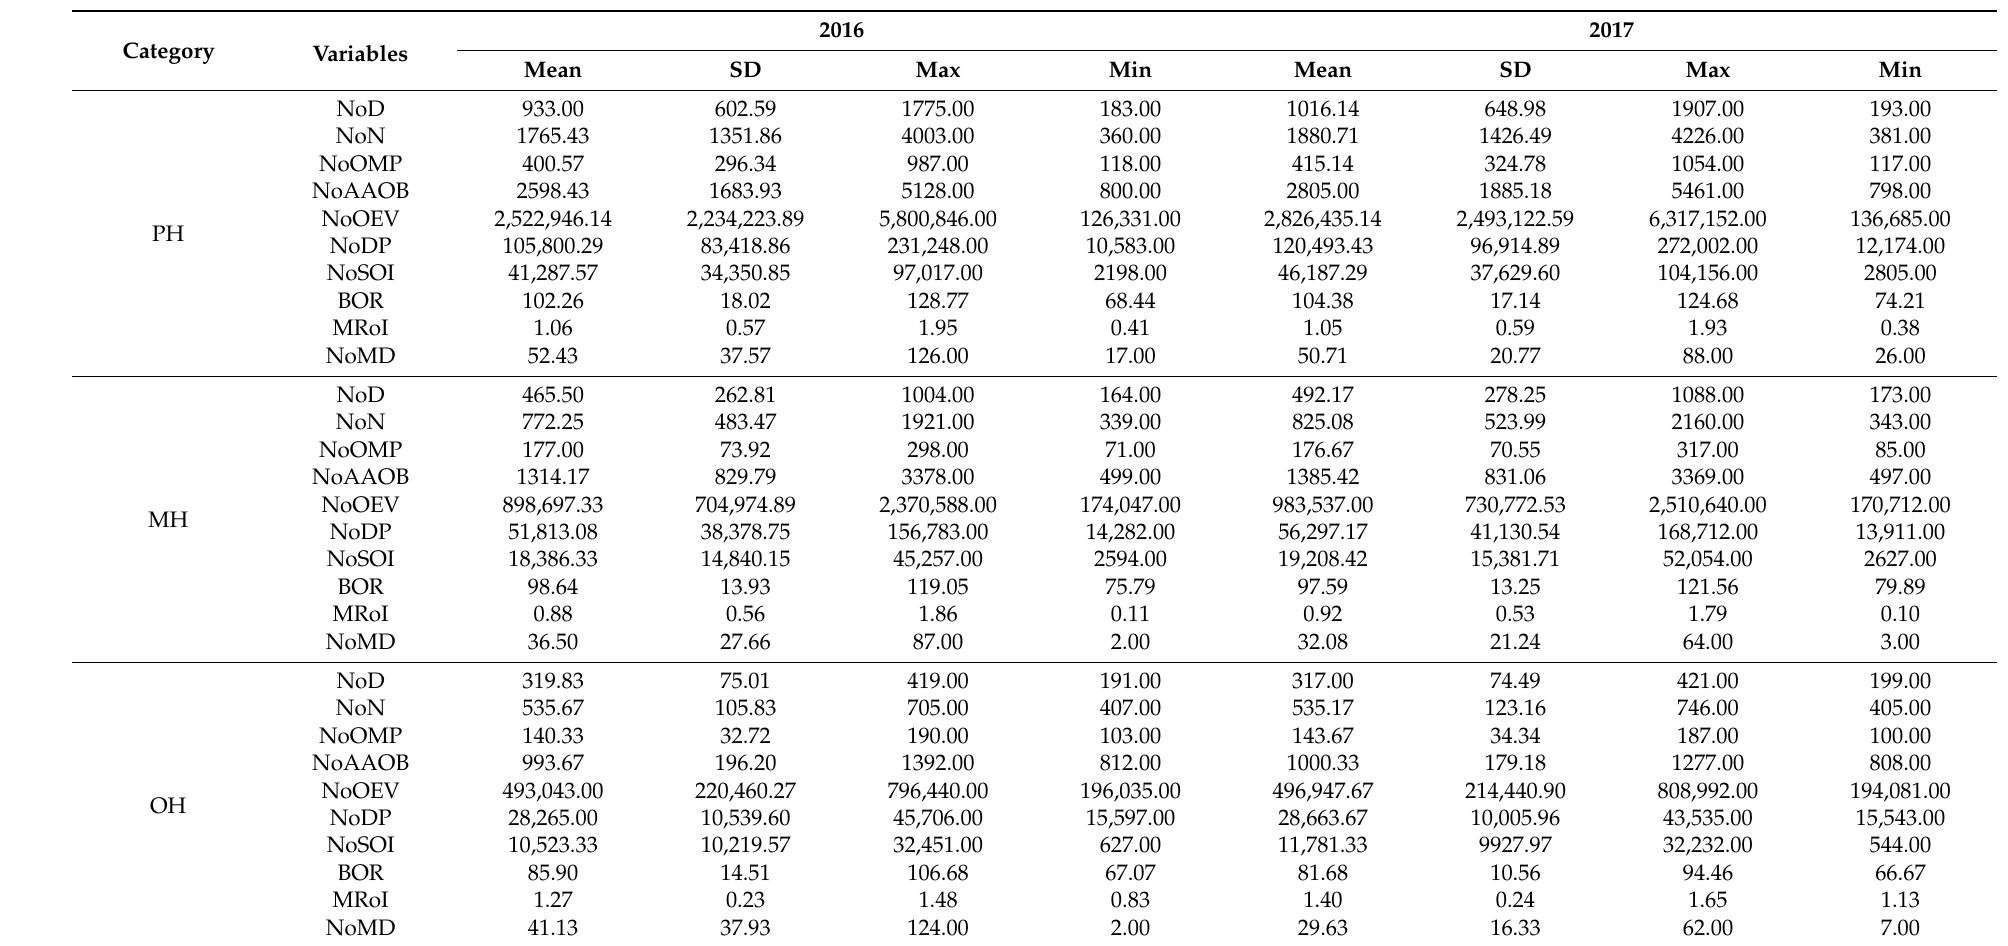
Table A2. Description statistics of input–output variables